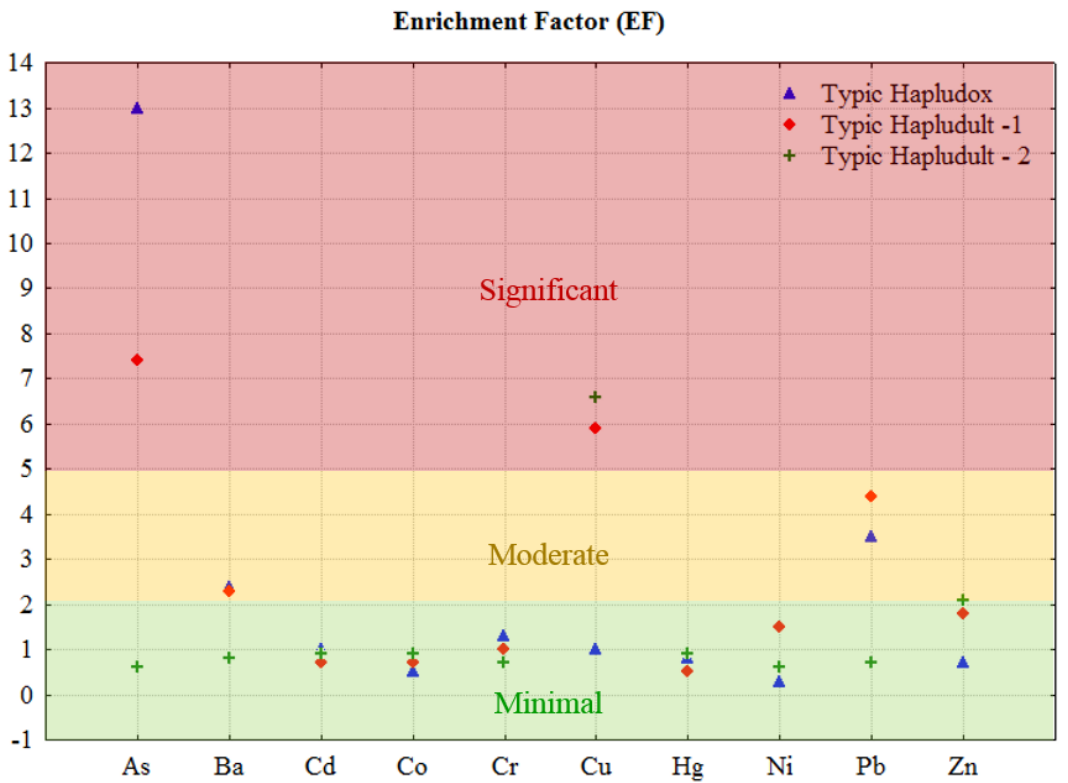
Figure 2. Enrichment factors of PTEs in areas cultivated with oil palm (Typic Hapludox), black pepper (Typic Hapludult-1) and citrus (Typic Hapludult-2). Table 2. Concentrations of potentially toxic elements in soils and quality guidelines.